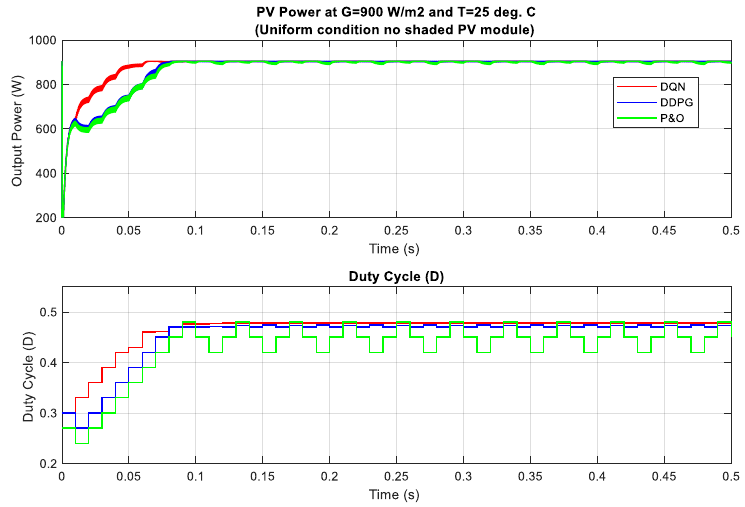
Figure 13. PV power under uniform condition with G = 900 W/m 2 . In the scenario with one shaded PV module, the irradiation on one PV module is reduced from 900 to 350 W / m 2 for testing the response of the proposed MPPT controllers. Additionally, the simulation results are described in Figure 14, in which the upper graph indicates the output power while the lower graph shows the duty cycle. Under this weather condition, the DQN and DDPG can detect the global MPP with a value of around 600 W, marked as the red line and blue line in the figure, respectively. The result reduces by about one third when compared with the uniform state. As can be seen in Figure 14, the green line indicates the result of the P&O method. It can only track the local MPP, resulting in lower power extraction. In this condition, the DDPG method has the highest tracking speed, as well as is the most e ffi cient. Thus, the e ffi ciency of the DDPG method increases by 44.6%, while that of the DQN method is just about 38.3% compared with the P&O method. Next, Figure 15 shows the result of the scenario with two shaded PV modules. In this condition, the values of irradiation on three PV modules are 900, 300, 350 W/m 2 , respectively. On the other hand, the irradiation values on PV modules of the scenario with three shaded PV modules are 500, 800, 600 W/m 2 , respectively, as shown in Figure 16. Similar to the scenario with one shaded PV module, both DQN and DDPG methods are inferior to the P&O method. In Figure 15, compared to the P&O method, the e ffi ciency of DQN and DDPG methods increase by 25.9% and 22.1%, respectively. As shown in Figure 16, these percentages of e ffi ciency are 0.56% and 0.92%. In this case, the P&O method can track the global MPP, however, it is still less e ffi cient than DQN and DDPG methods. It is noted that the DDPG method can extract more power than the DQN based method in the scenarios with one and three shading PV